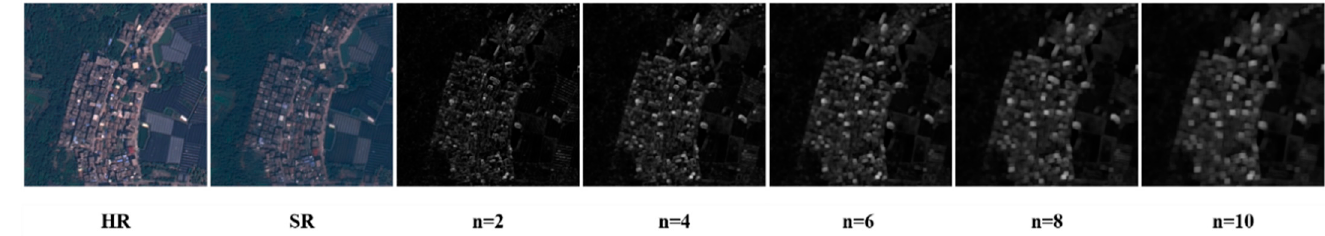
Figure 3. Visualization of the local variance maps at different n values in Equation (2). HR and SR represent the outputs of the GAN model and the HR image, respectively.